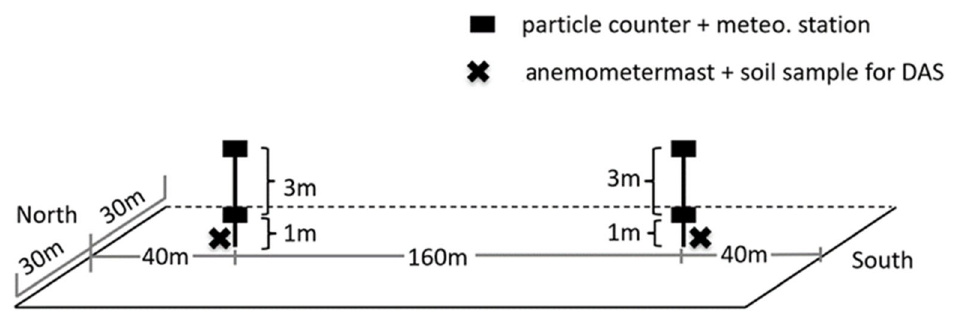
Figure 2. Experimental setup of the dust monitor, the meteorological. Two compact all ‐ in ‐ one ‐ weather stations (WS500 ‐ UMB, Lufft Mess ‐ und Regeltech ‐